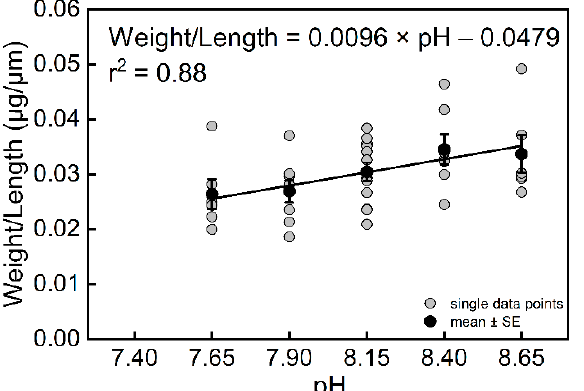
Figure 5. The relationship between weight/length of T. sacculifer and seawater pH. Note: There were no living T. sacculifer under the pH 7.40 treatment, and data from this treatment were not analyzed for regression. Error bar = SE.